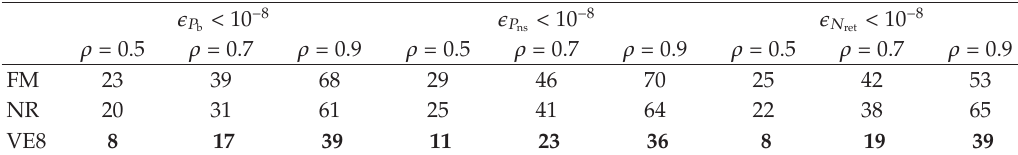
Table 3: Minimum Q value to obtain relative errors (cid:5) (cid:9) (cid:6) lower than 10 − 8